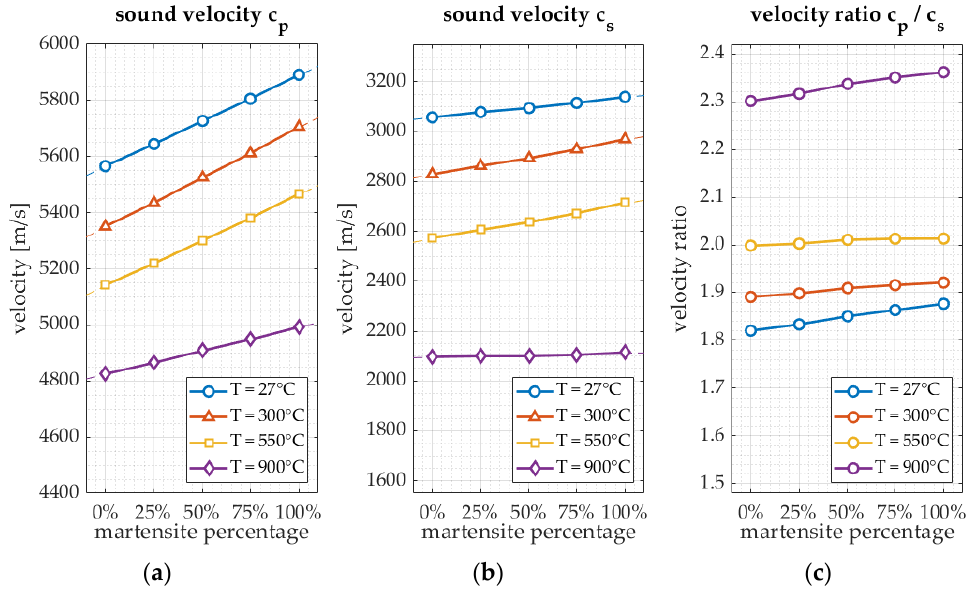
Figure 19. ( a ) The theoretical bulk pressure wave velocity c p ; ( b ) the theoretical bulk shear wave velocity c s ; and ( c ) their ratios c p / c s , as function of the martensite percentage for the martensite/austenite sample.